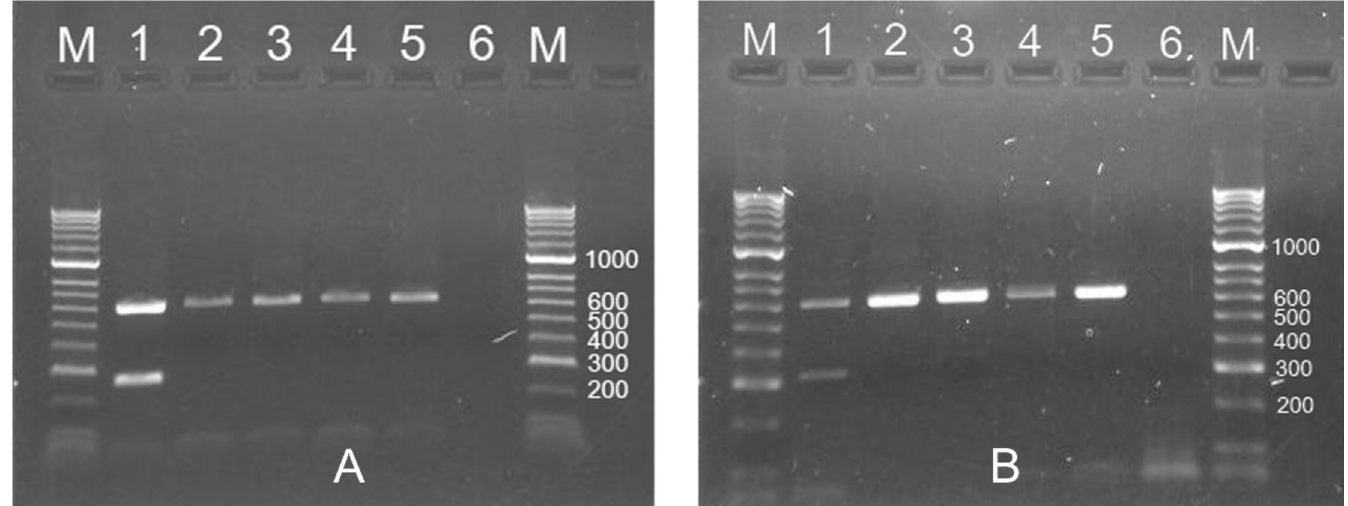
Fig 5. Duplex PCR results for two common Meloidogyne species from turfgrass using ITS species-specific primers plus 28S universal primers. A. Duplex PCR results using M . graminis -specific primers (MgmITSF/MgITSRs) plus RK28SF/MR. M: HyperLadder II DNA Marker; 1: M . graminis (DNA ID: 48); 2: M . marylandi (2); 3: M . naasi (22); 4: M . incognita (19); 5: M . graminis (48) (only RK28SF/MR); 6: Water. B. Duplex PCR results using M . marylandi -specific primers (MgmITSF/MmITSRs) plus RK28SF/MR. 1: M . marylandi (2); 2: M . graminis (48); 3: M . naasi (22); 4: M . incognita (19); 5: M . marylandi (2) (only RK28SF/MR); 6: